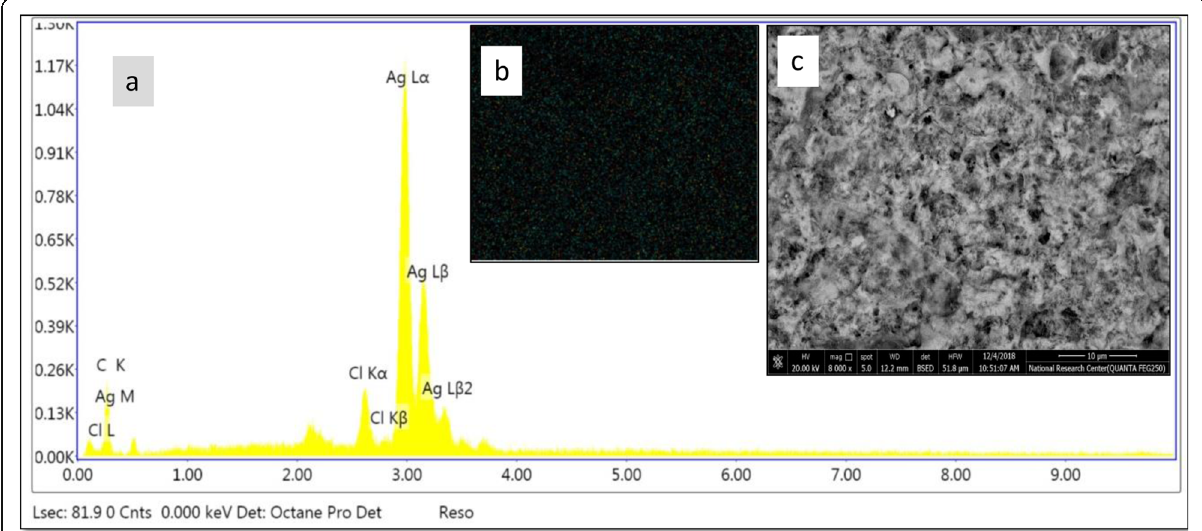
Fig. 3 Profiles of the biosynthesized AgNPs by A. fumigatus DSM819 CFF. a EDAX profile of nanosilver and other combined metals. b Magnified SEM micrograph (× 8000). c EDAX mapping micrograph showing AgNP percentage as turquoise ( ) dots in the total sample black background. Samples used were produced from reaction mixture containing 60% from A. fumigatus CFF and 1.5 mM AgNO 3 and incubated for 90 min at pH